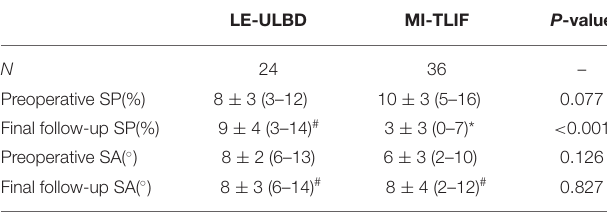
TABLE 3 | Radiologic evaluation of the two